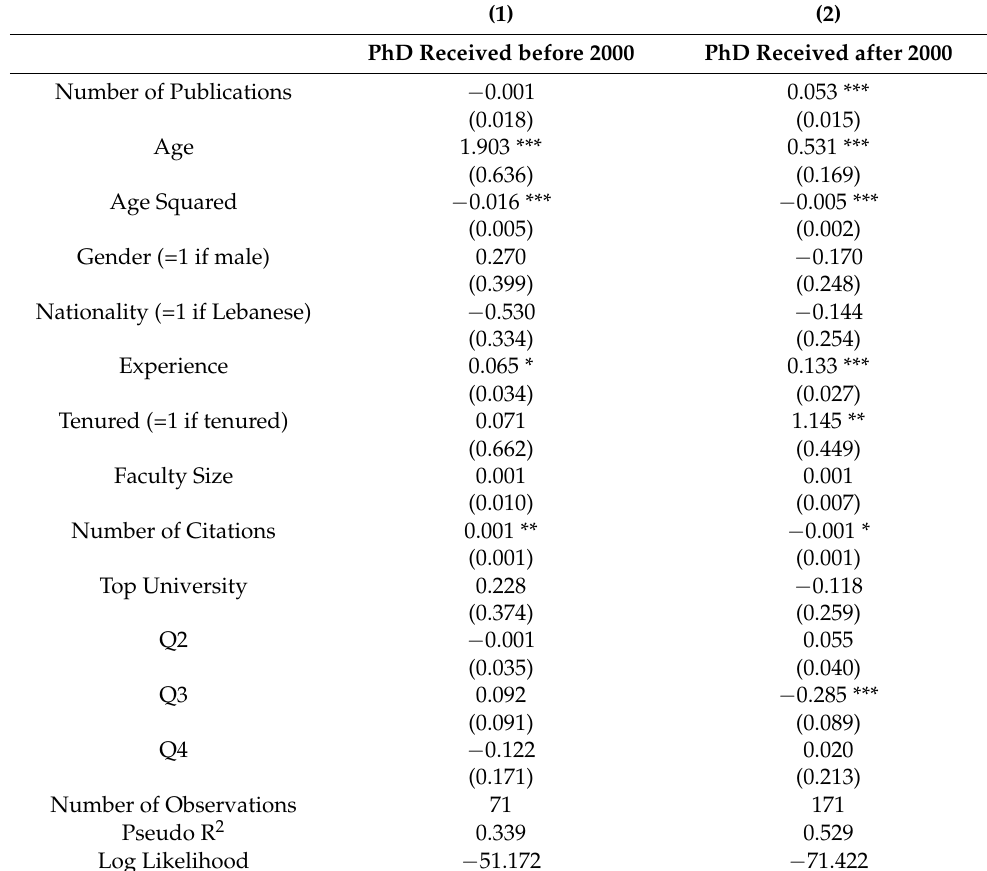
Table 4. Results of the Ordered Probit model, results by faculty